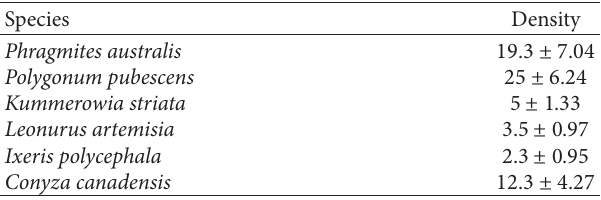
Table 1: Density of the studied